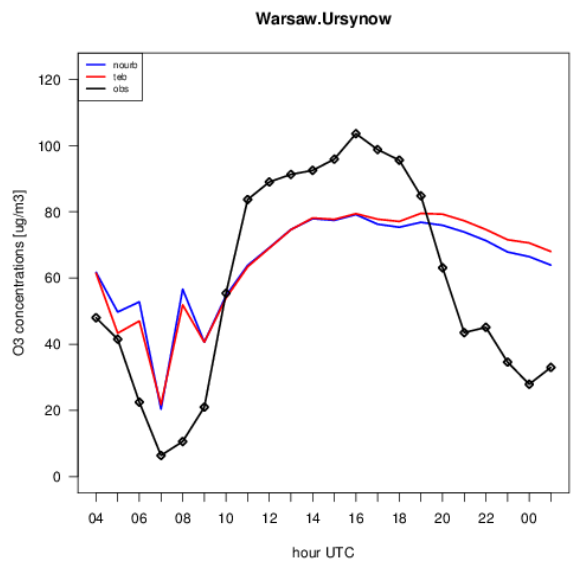
Fig. 16. Comparison of modelled O 3 concentrations with observa- Figure 16 Comparison of modelled O tions from station Warsaw-Ursynow for 29 March 2011 (red line - urban scenario, blue line - non-urban scenario, black line - observa- Warsaw-Ursynow for 29 th of March 2011 (red line – urban scenario, blue line = non-urban